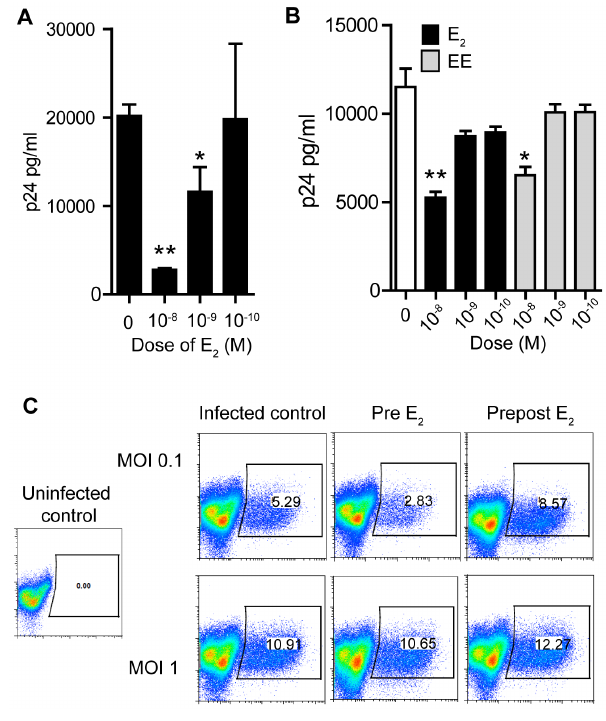
Figure 4. Dose response effect of E 2 on HIV-infection. A) Released p24 levels in the culture media after 7 days of infection when CD4 + T-cells where pre-treated with indicated doses of E 2 . Bars represent mean 6 SEM from triplicates. Representative of 3 indepen- dent experiments with different donors. *P , 0.05 **P , 0.01. B) Released p24 levels in the culture media after 7 days of infection when macrophages where pre-treated with indicated doses of E 2 (black bars) or EE (grey bars). Bars represent mean 6 SEM from triplicates. Representative of 3 independent experiments with different donors. *P , 0.05 **P , 0.01. C) Percent of GFP positive cells after infection with HIV-GFP at MOI 1 or MOI 0.1 in CD4 + T-cells pre-treated with E 2 (pre E 2 ) or treated before and after infection (prepost E 2 ).